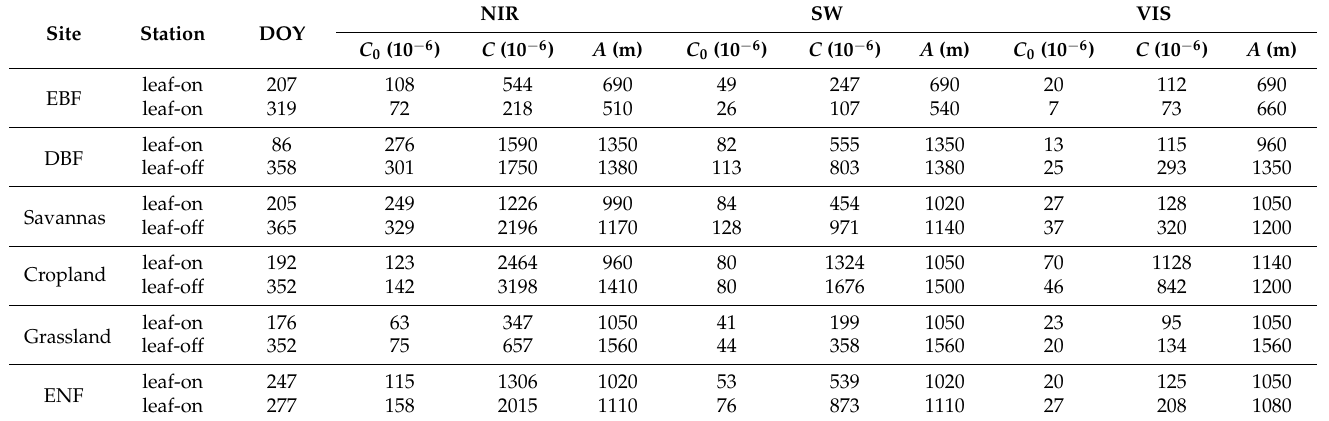
Table 3. Statistics of semi-variogram parameters for each study